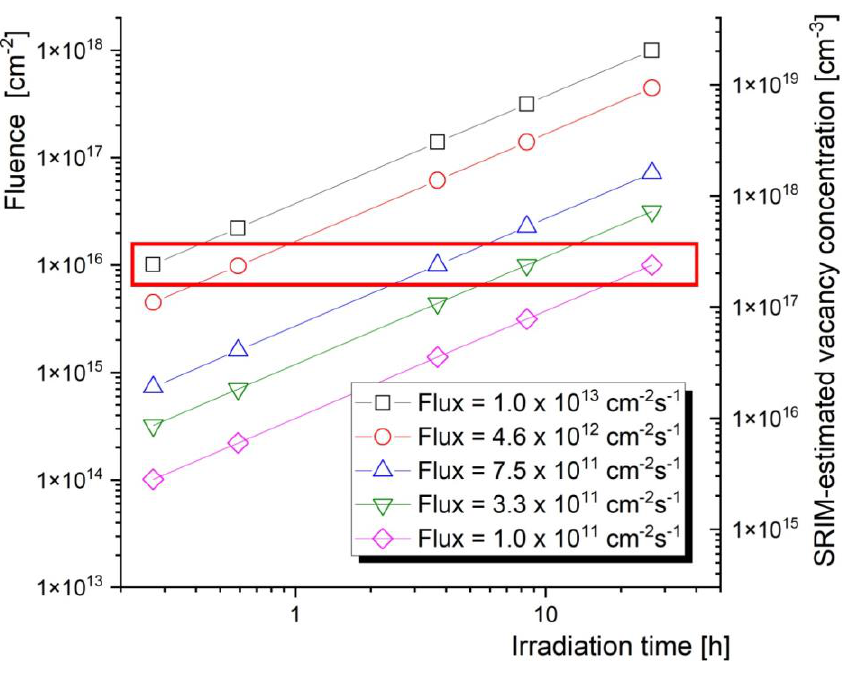
Figure 4. Fluence vs. irradiation times for different proton fluxes (beam currents) used in the experiment.